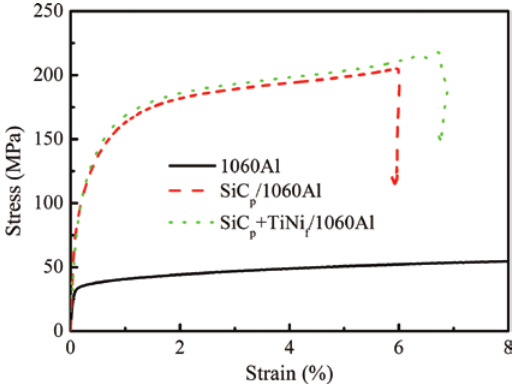
/Al, and SiC +TiNi /Al p p f